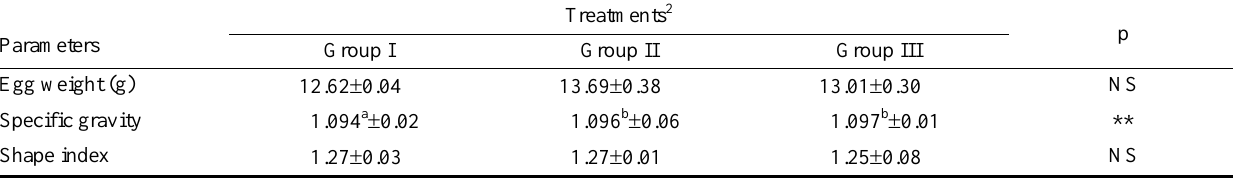
Table 3. The effect of different doses of dietary L-ascorbic acid (L-AA) supplementation on external egg quality in laying Japanese quail